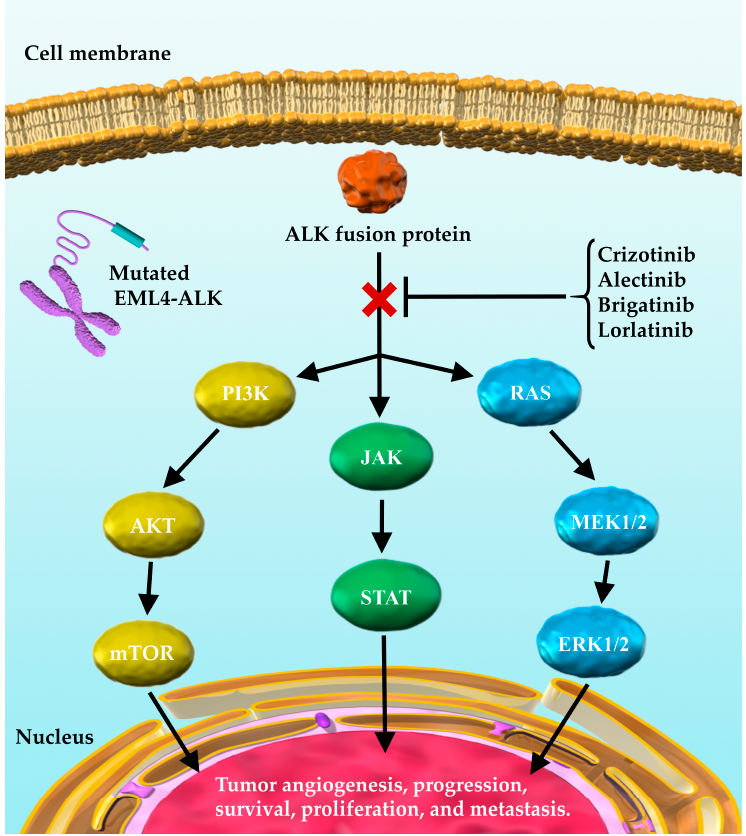
Figure 1. ALK fusion proteins and their downstream signaling pathways involved in tumor progression. EML4-ALK ac- tivates PI3K-AKT, RAS, and JAK/STAT signaling cascades through the ALK fusion protein. This in turn affects tumor progression, survival, and growth. ALK inhibitors, such as crizotinib, alectinib, brigatinib, and lorlatinib exert their anti- tumor effects by acting on mutated ALK and inhibiting the effects of ALK fusion proteins on downstream signaling. EML4- ALK, echinoderm microtubule-associated protein-like 4-anaplastic lymphoma kinase; ALK, anaplastic lymphoma kinase; PI3K, phosphatidylinositol-3 kinase; mTOR, mammalian target of rapamycin; RAS, reticular activating system; MEK, mi- togen-activated extracellular signal regulated kinase; ERK, extracellular signal-regulated kinase (ERK); JAK, Janus kinase; STAT, signal transducer and activator of transcription. Lorlatinib, a third-generation ALK inhibitor, was approved by the US food and drug administration (FDA) as an orphan drug for NSCLC in 2015 and as the second- or third- line treatment for ALK-p advanced NSCLC in 2018 [27]. In Japan, lorlatinib became avail- able in 2018 for use in ALK-p advanced NSCLC that had relapsed or were refractory to ALK inhibitors [24]. It has been reported that lorlatinib is effective in cancers harboring mutations in ALK that conferred resistance to ALK inhibitors, including G1202R and I1171N mutations [28,29]. A remarkable feature of lorlatinib is that it is designed to cross the blood–brain barrier. This makes it highly effective for the treatment of ALK-p ad- vanced NSCLCs, even those with CNS metastases [16,28–30]. Several in vivo studies have